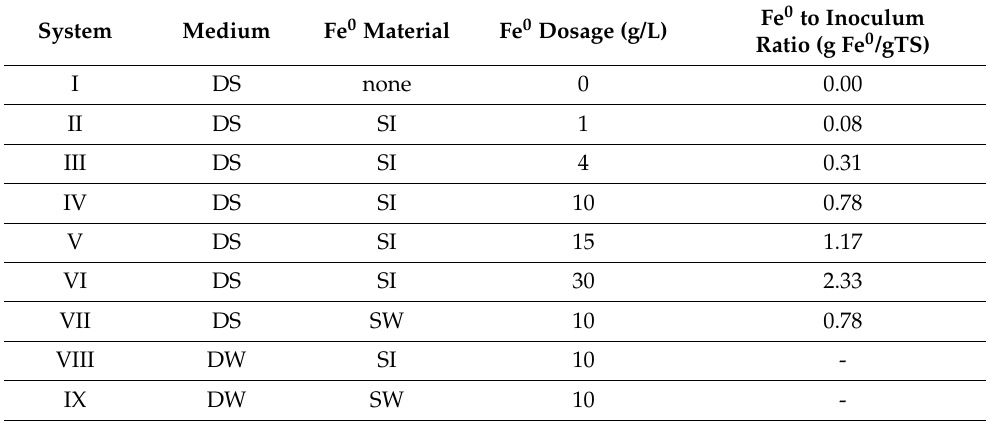
Table 2. Identities of reactors used in tested reactors. Each system contains 3000 mL of the medium (DS or DW). DS stands for domestic sewage, DW for distilled water, SI for scrap iron and SW for steel wool. The accuracy in measurements of Fe 0 materials’ dosages was 0.1 mg Fe 0